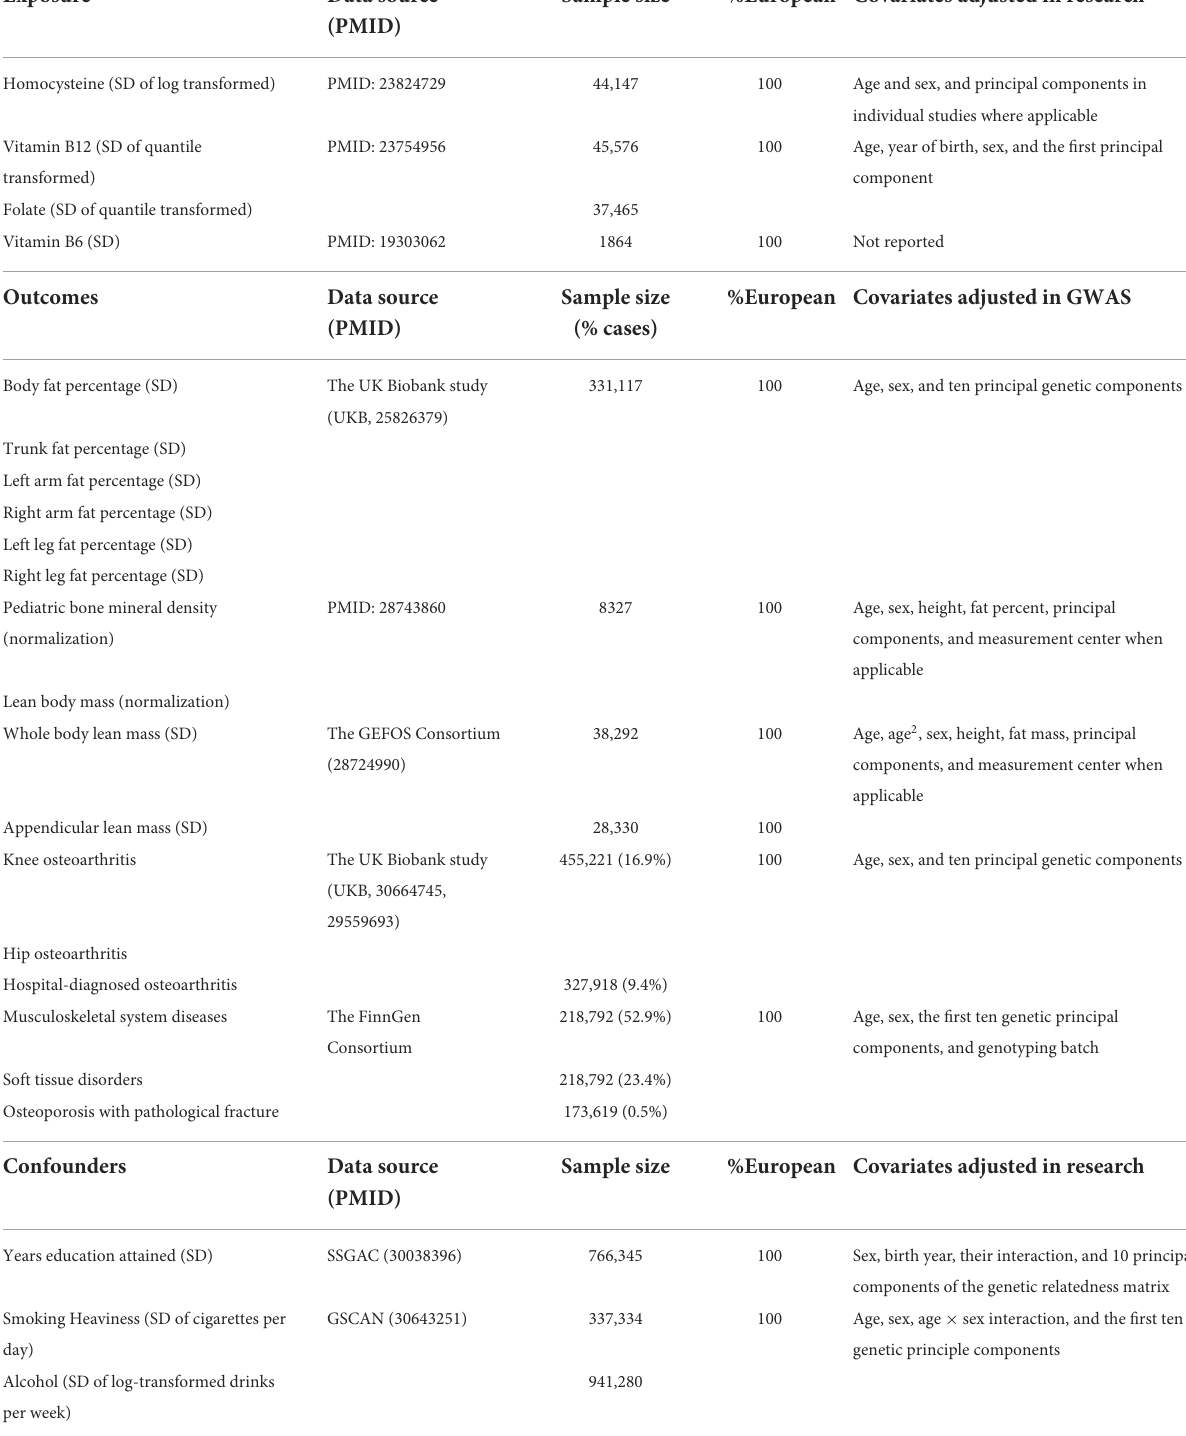
TABLE 1 Information on the genome-wide association studies utilized in this Mendelian randomization